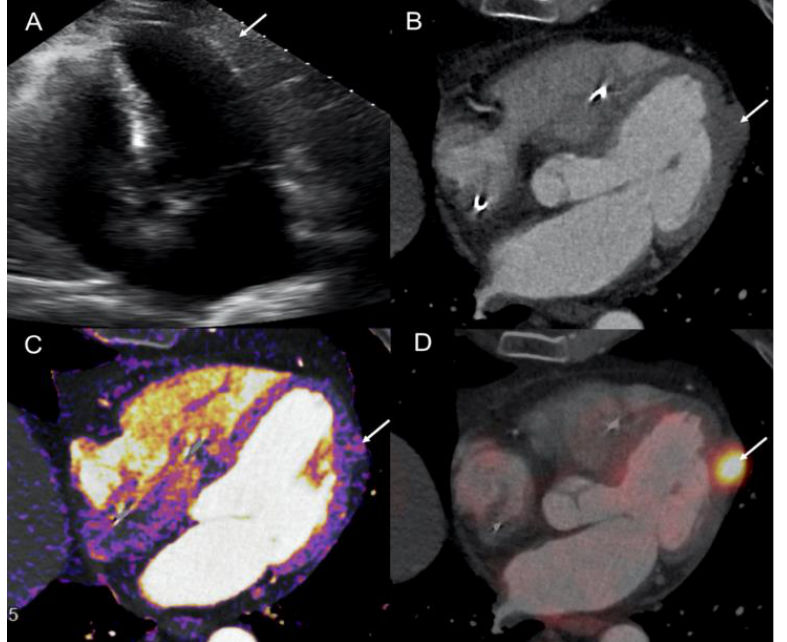
Figure 2. Patient 1 . TTE (5-chambers view) showed isoechogeneous mass (arrow) in the latero-apical LV wall ( A ). Contrast-enhanced ECG-gated cardiac-CT (4-chambres view) confirmed the presence of a myocardial metastasis (arrow) with pericardial infiltration ( B ). No significant tumoral contrast-enhancement was detectable at visual analysis. Conversely, iodine mapping analysis revealed a heterogeneous, mild, and peripheral enhancement of ventricular metastasis (arrow) ( C ). Fused 18 F-DOPA PET/Contrast-enhanced ECG-gated cardiac-CT images ( D , 4-chamber view).